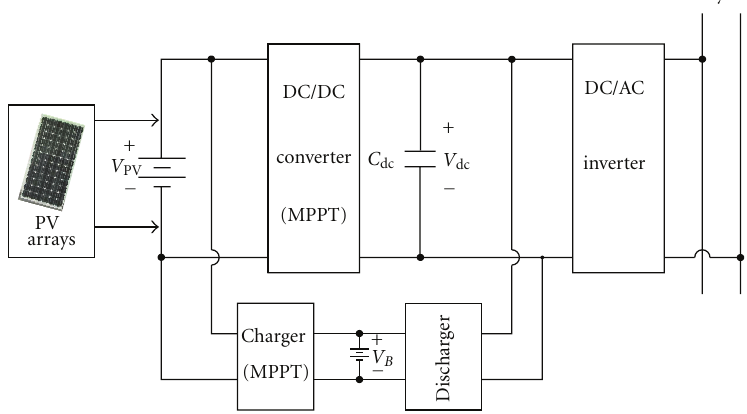
Figure 1: Block diagram of a typical PV power system.